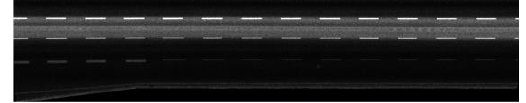
Figure 11. Intensity